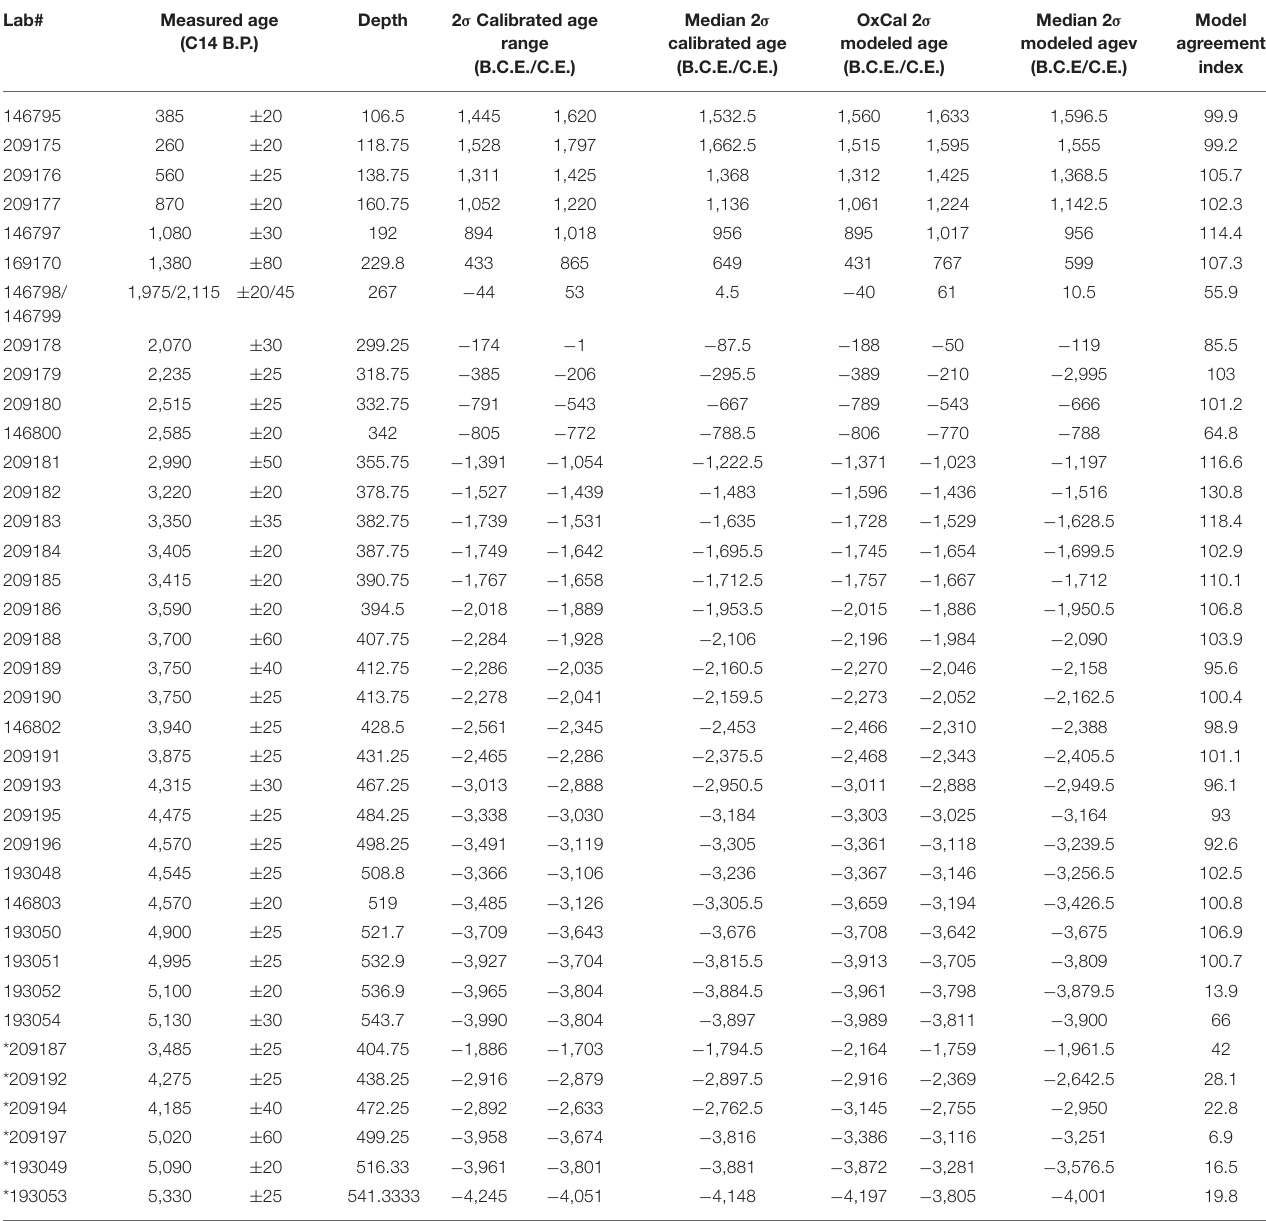
TABLE 1 | Measured, calibrated, and modeled radiocarbon ages for Cenote Kail. Lab# Measured age (C14